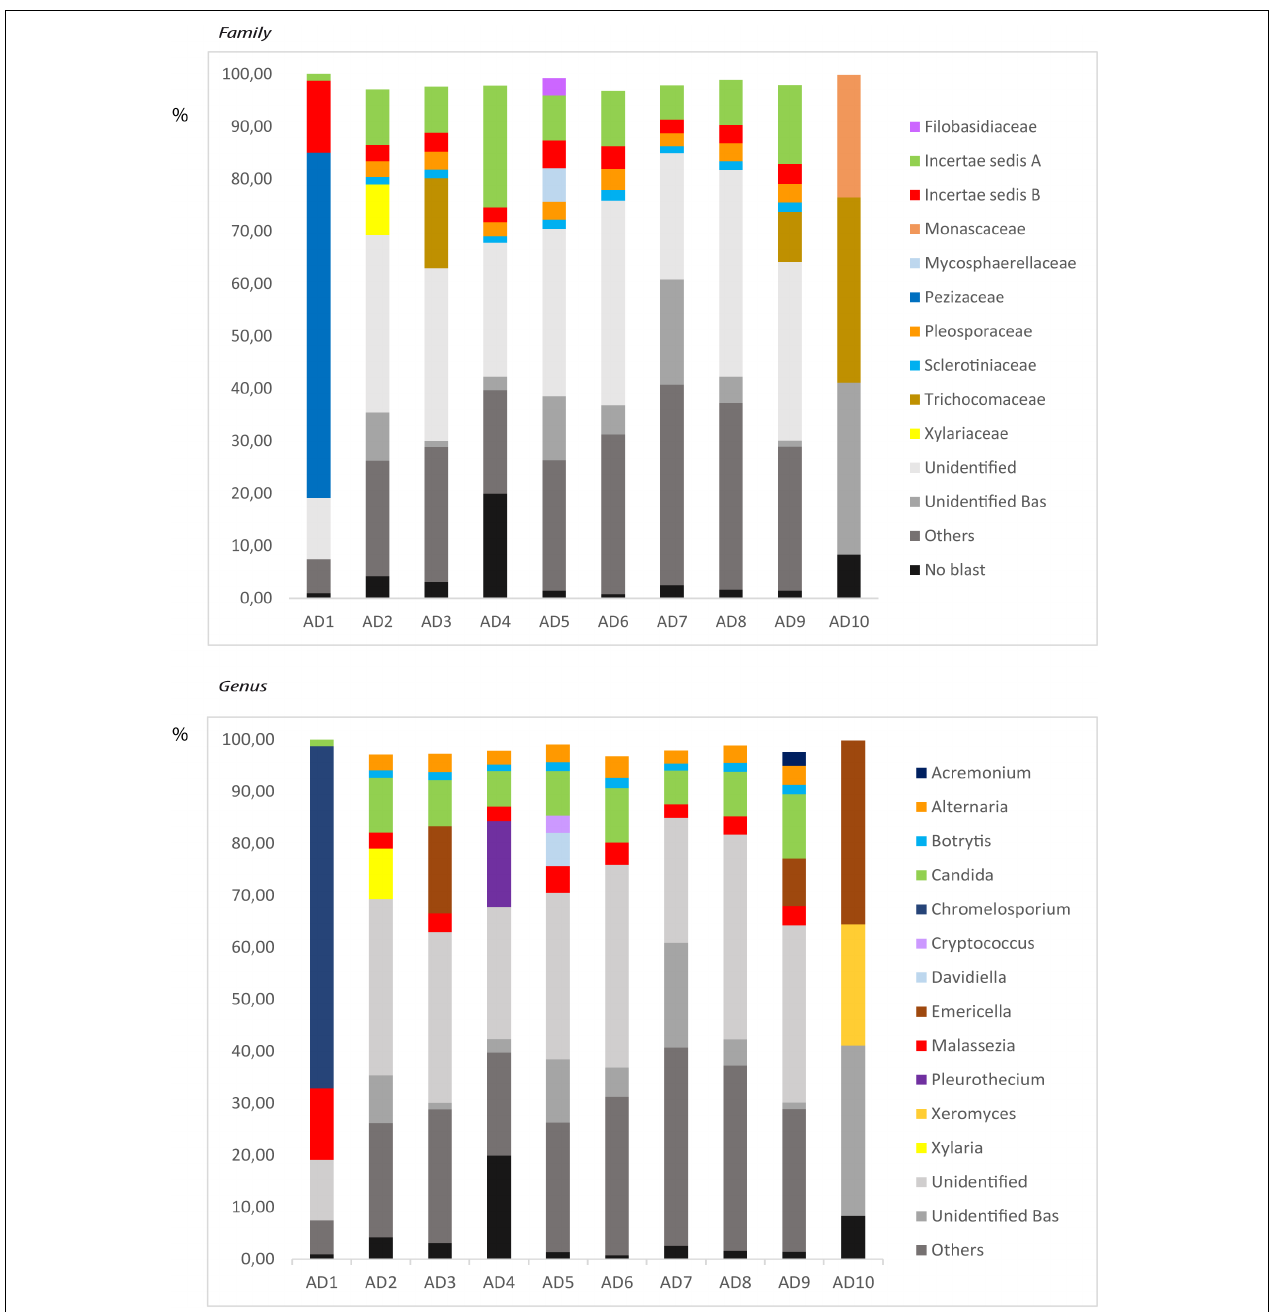
FIGURE 3 | Distribution of fungal families and genera obtained by NGS of DNA from ten AD patients. Computational analyses of the sequences obtained on the Illumina platform using Qiime classified the data into fungal families and genera. (Upper) Shows the results of fungal families obtained from FC of AD patients. (Lower) Shows the results of fungal genera obtained from FC of AD patients. Asc, Ascomycota ; Bas, Basidiomycota ; Chy , Chytridiomycota